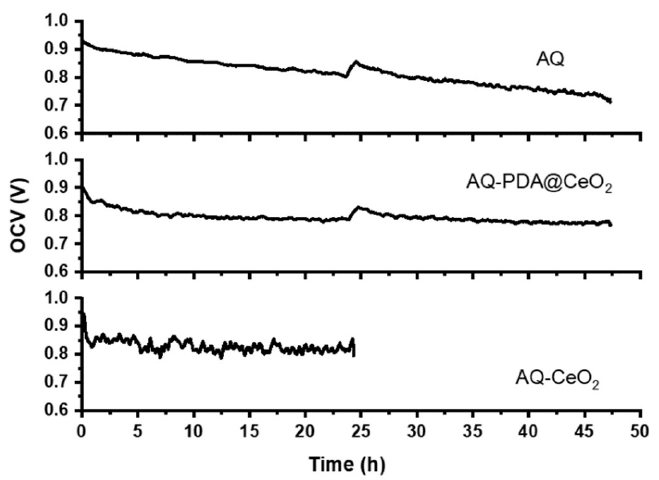
Figure 11. OCV vs. time curves for AQ, AQ-PDA@CeO 2 and AQ-CeO 2 membranes.